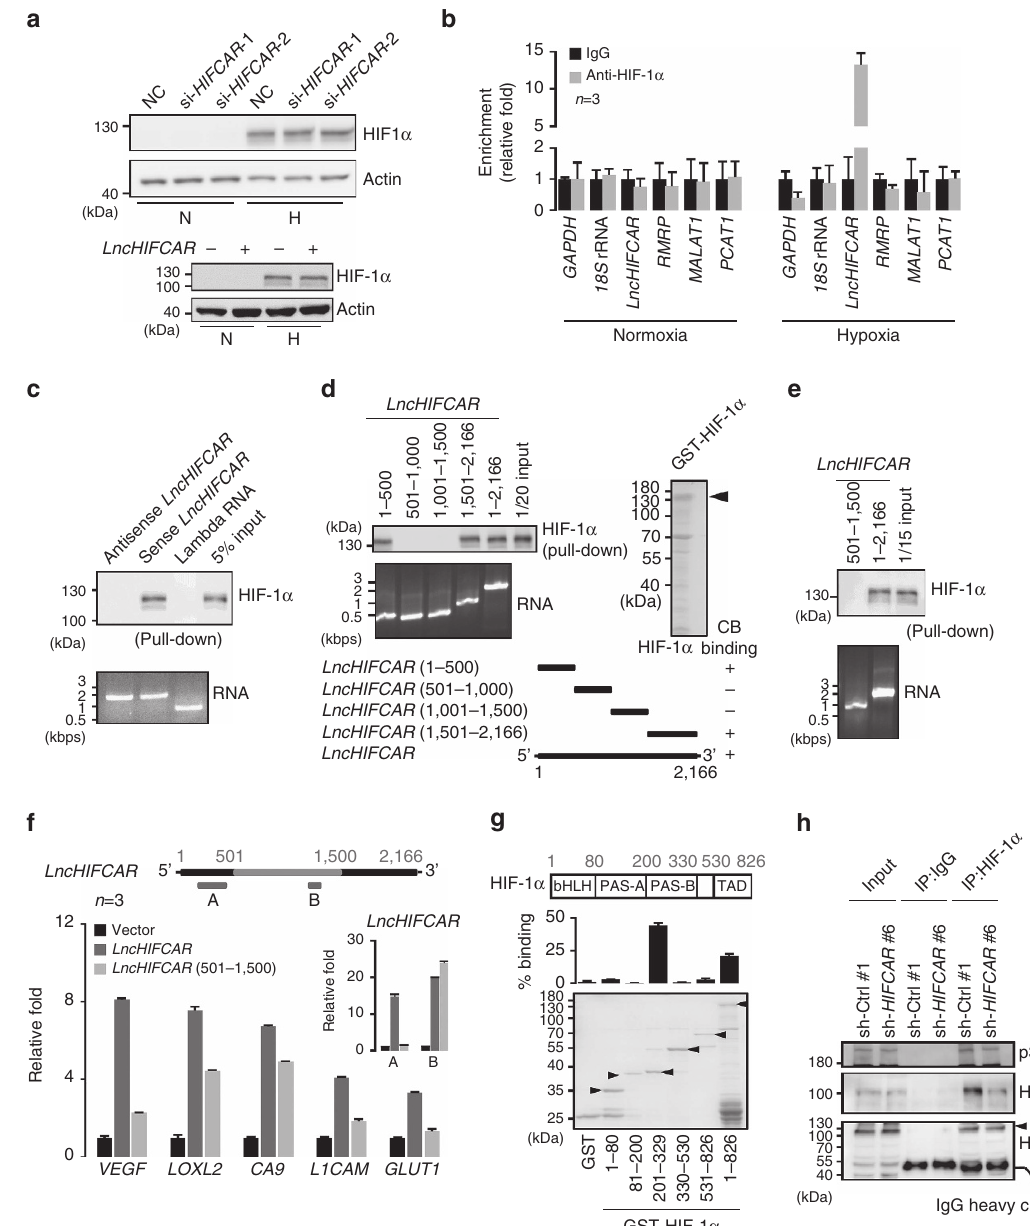
Figure 4 | lncRNA LncHIFCAR associates with HIF-1 a and functions as a HIF-1 a co-activator. ( a ) Representative ( n ¼ 3) western blot analysis of HIF-1 a protein levels in LncHIFCAR -overexpressing HeLa cells and controls (lower panel), or in siRNA-transfected SAS cells (upper panel) under 24h of normoxia (N) or hypoxia (H) treatment. NC, negative control. ( b ) lncRNA LncHIFCAR enriched in HIF-1 a immunoprecipitates under hypoxia. Sixteen